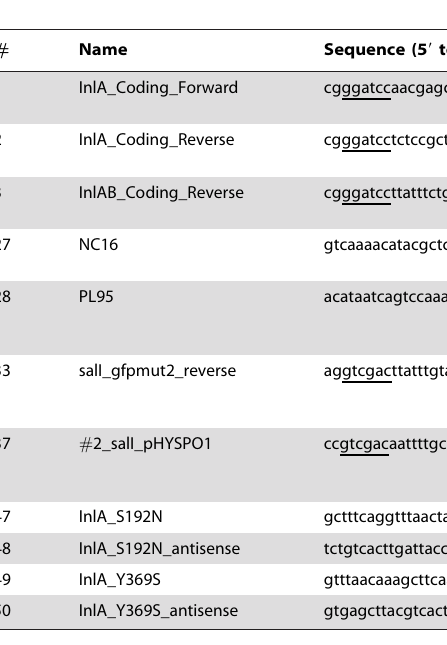
Table 1. Oligonucleotides Used in This Study.